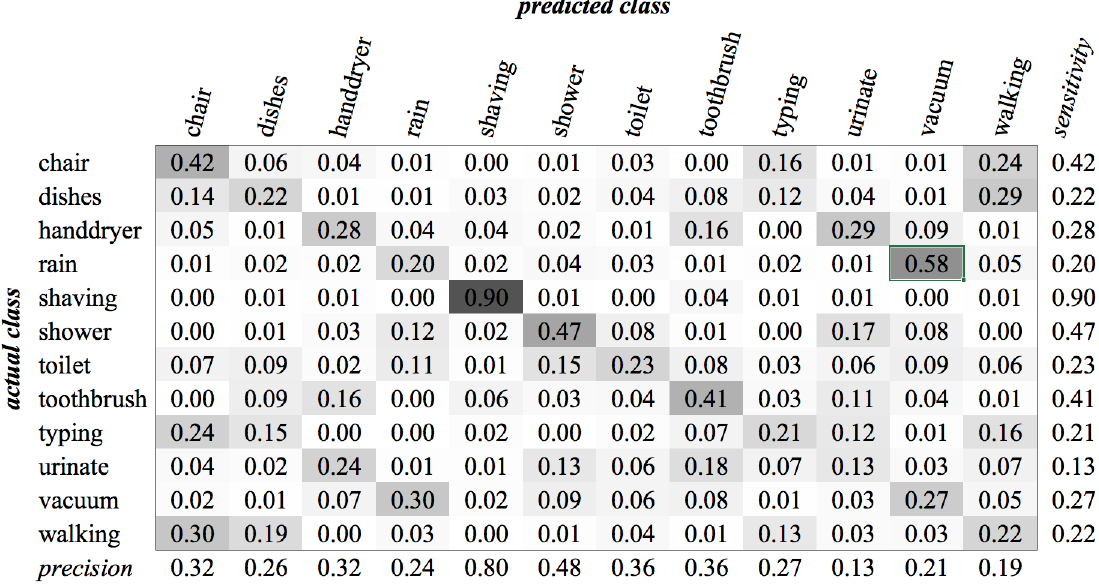
Figure A10. KHMM confusion matrix of category Environment for MFCC feature type.